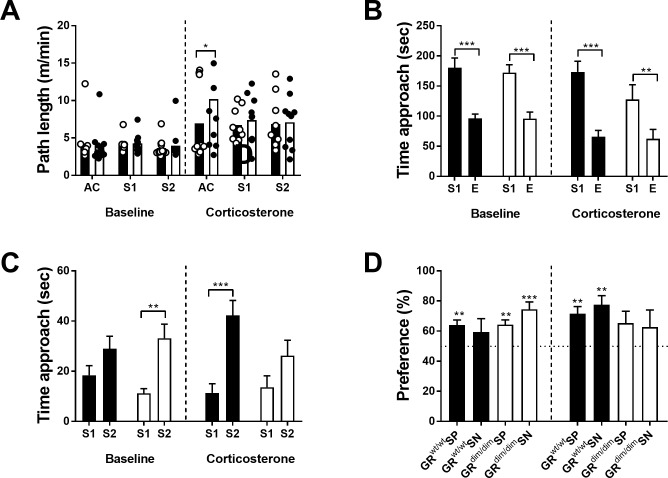
Sociability (SP) and preference for social novelty (SN) in GRwt/wt (black bars) and GRdim/dim mice (white bars) under baseline and under chronic corticosterone treatment.Under baseline conditions, no difference in path length (m/min) was observed between the genotypes.CORT treatment increased path length (m/min) in both genotype similarly in comparison to baseline (A). When presented with a stranger mouse (S1), under baseline and CORT conditions, both genotypes showed more approach behaviour towards S1 than to an empty (E) cage (B). When presented with a second stranger (S2), under baseline conditions GRdim/dim mice show a preference towards S2, while under CORT treatment, GRdim/dim mice do not display preference towards S2 anymore (C). Calculation of individual preference scores indicate that under baseline conditions, both genotypes show normal social preference (SP: S1-E), however, only GRdim/dim mice show preference for social novelty (SN: S1-S2). Under CORT, GRwt/wt show preference during SN and SP, while GRdim/dim mice show no preference in SP and SN (D). Data are shown as means ± SEMs. (B-D) * p < 0.05, **p < 0.01 ** p < 0.01, ***p < 0.001, (one sample t-test to chance level at 50%). Baseline: n = 12 GRwt/wt and n = 11 GRdim/dim mice; CORT: n = 9 GRwt/wt and n = 10 GRdim/dim mice.